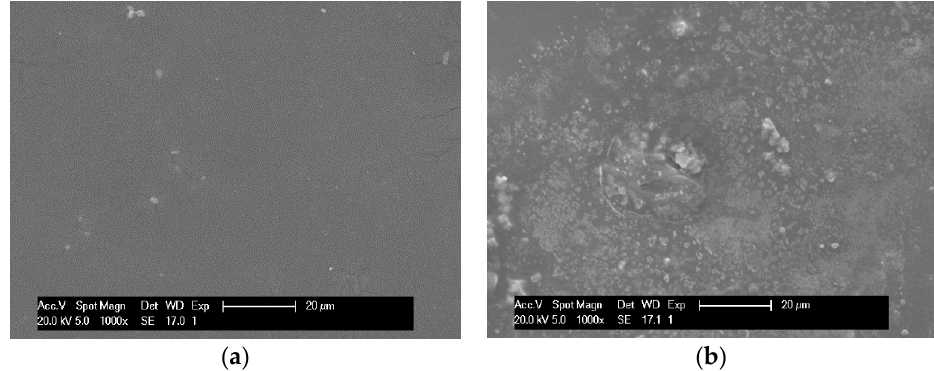
Figure 8. SEM micrographs of ( a ) virgin NF and ( b ) fouled NF membrane.